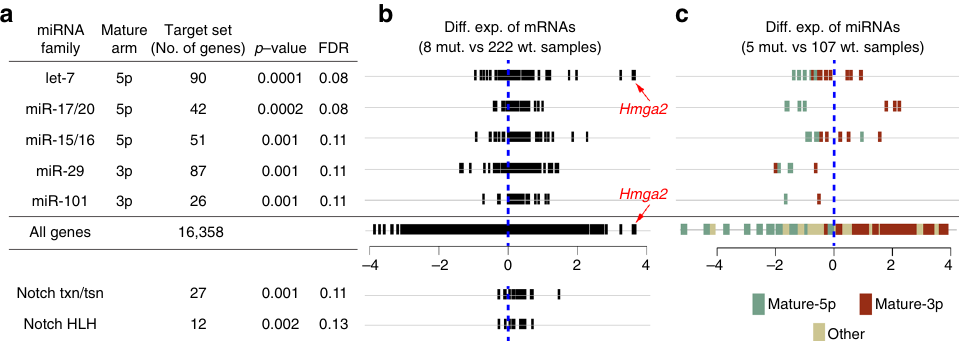
Fig. 6 Gene expression signatures of DICER1 hotspot UCEC tumors. a Gene-set enrichment analysis (GSEA) on mRNA pro fi les of DICER1 RNase III hotspot cases in uterine corpus endometrial cancer (UCEC). Shown are all enriched sets in RNase III hotspot samples; fi ve are miRNA target sets and two relate to Notch pathway targets. b The expression distributions of all enriched gene sets were preferentially upregulated in DICER1 mutants compared to wildtypes. HMGA2 , a well-known oncogene and let-7 target, was the most-deregulated gene. c For each of the three mature-5p miRNA families, we saw consistent downregulation of 5p strand (green) and upregulation of 3p strand (red) miRNA members in DICER1 hotspot mutants. For the mature-3p miRNA families, both arms were downregulated in mutants. mut: DICER1 hotspot mutant; wt: DICER1 wildtype; Diff. Exp.: Differential expression (log 2 ratio of mRNA/ miRNA levels); p -value: The probability for the null hypothesis that the genes in the set are not differentially upregulated in mutants compared to wildtypes; FDR: p -value corrected for multiple hypothesis